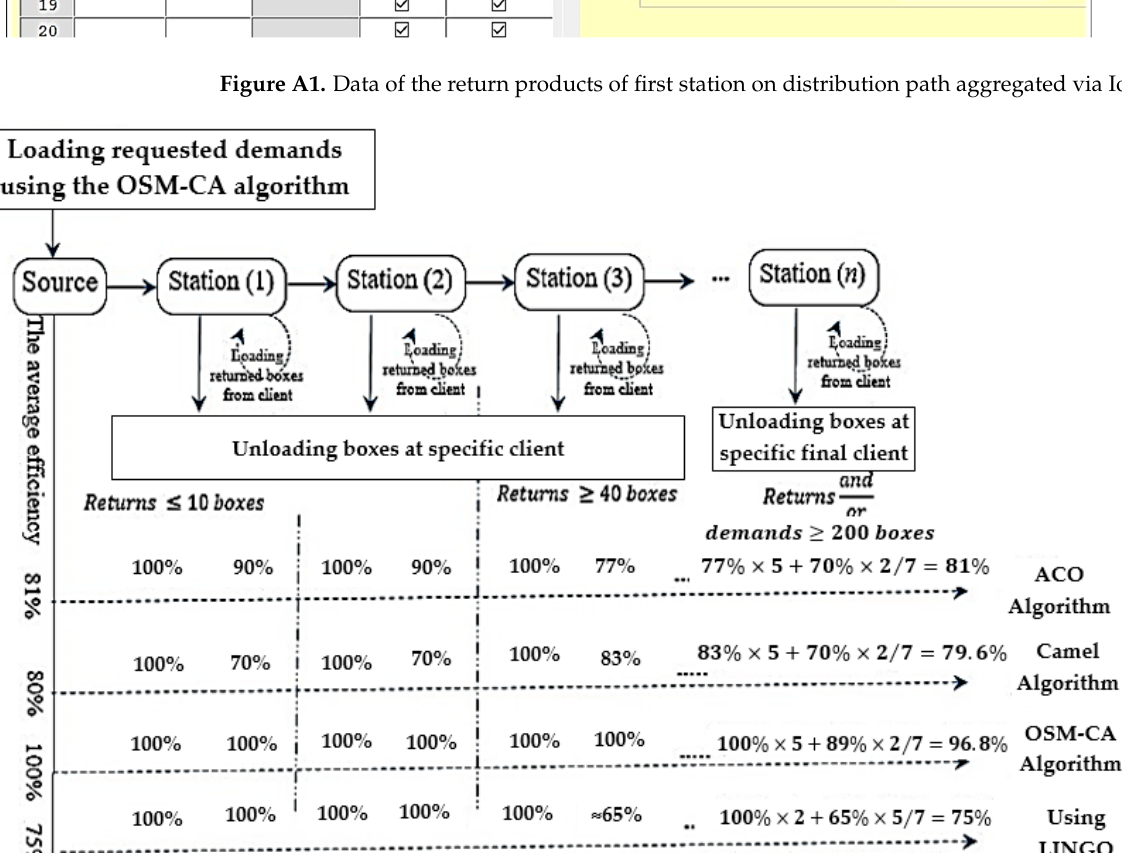
Figure A3. Safety distance of the return products when stowage [0: < Y].